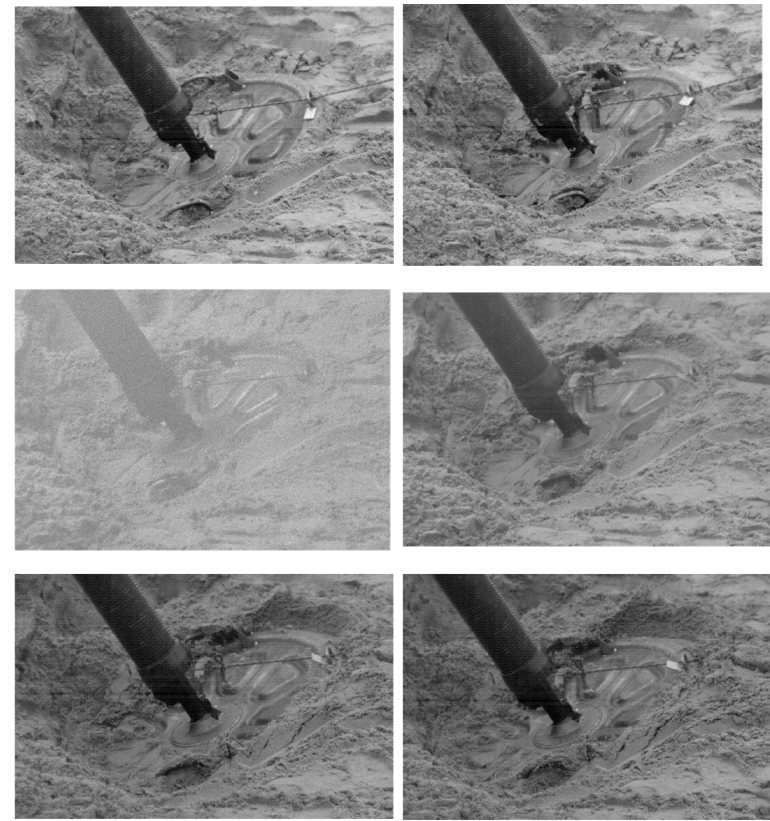
Figure 4. Mortar’s recoil process on sandy